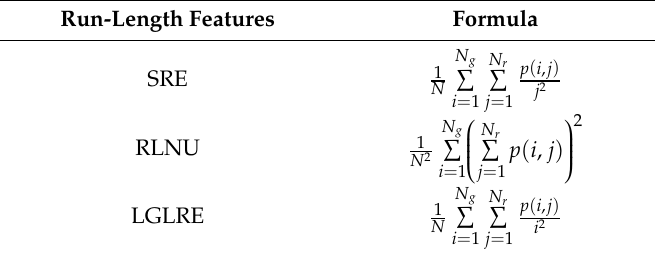
Table 2. Mathematic description of the most important identified features of Run Length approach. Run-Length